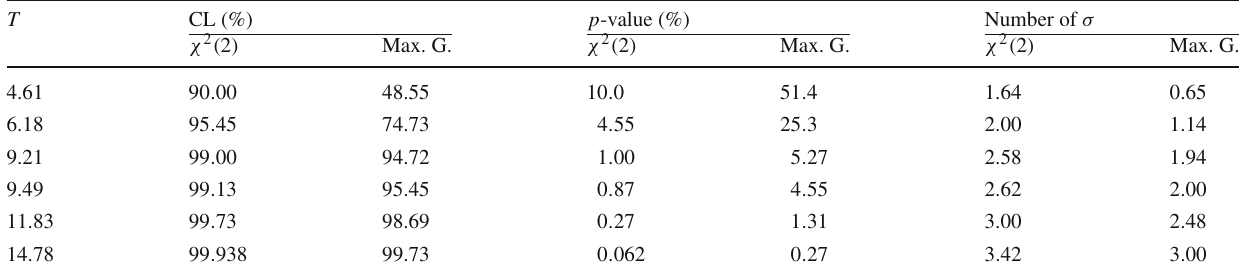
Table 1 Comparison of the confidence level (CL), p -value, and corresponding number of standard deviations ( σ ), for several values of T , obtained for a χ 2 distribution with 2 DOF and for the max. Gauss distribution for N =